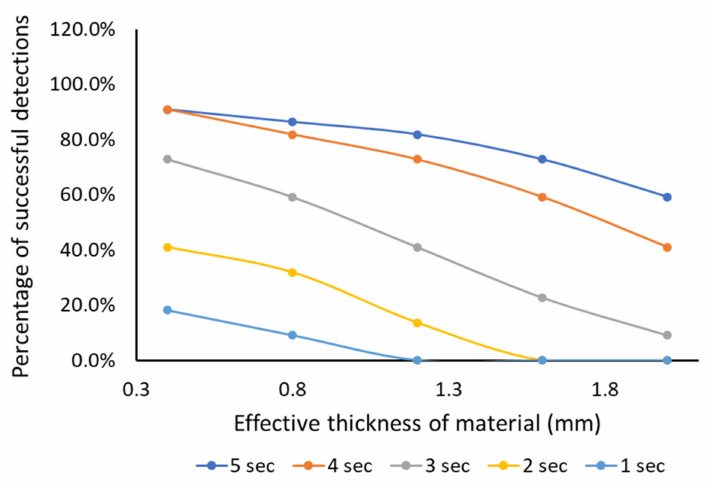
Figure 9. Performance of capacitive slider sensor in the smart textile (items 1 and 2 in Figure 3b). For a stroking time of 5 s, as the effective material thickness increases from 0.4 mm, the percentage of successful detections of the correct sequence reduces by 33% from 90%. The reduction only indicates the sensor is failing to generate the pre-set correct